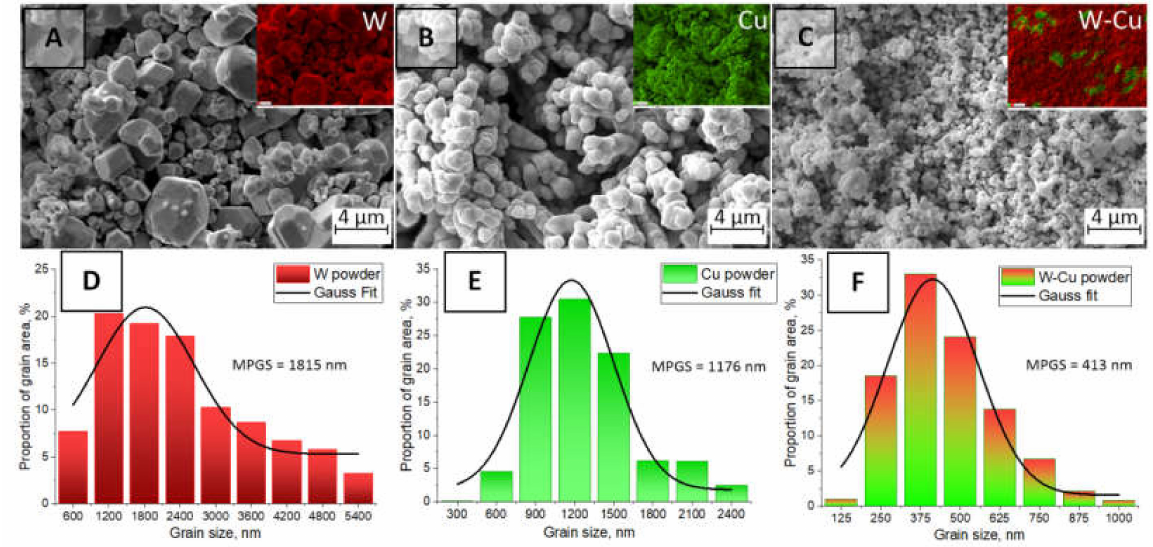
Figure 3. SEM images of the initial W powder ( A ), Cu powder ( B ), mixed and milled W–Cu powder ( C ), and corresponding grain size distribution ( D – F ). Inserts: EDX maps of elemental distribution.